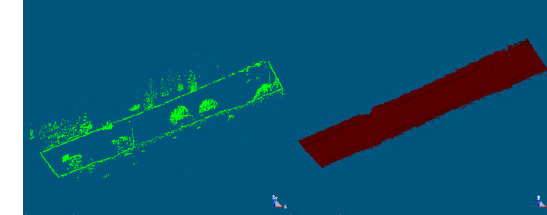
Figure 12. Auriga Dr. Left: Non-ground. Right: Refined ground segment.